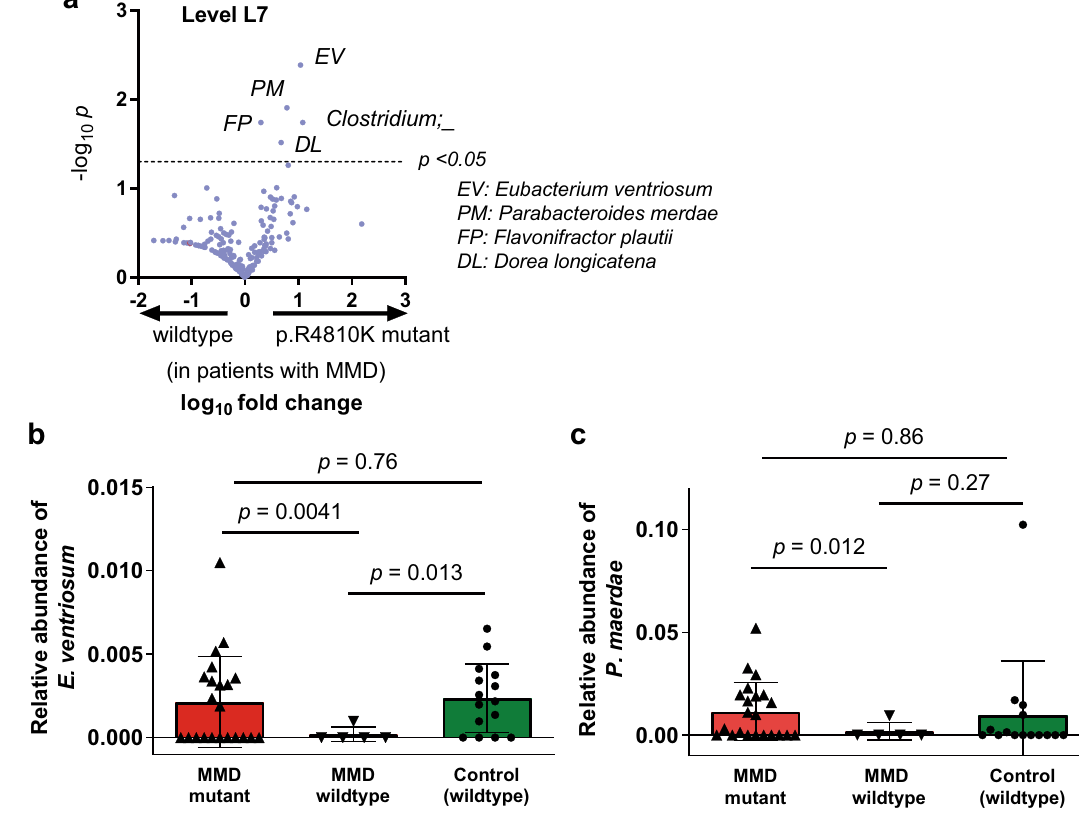
Figure 6. Relative abundance analysis of gut microbiota according to the p.R4810K mutation. ( a ) Relative abundances of gut microbiota were compared between MMD patients with the p.R4810K mutation and those without it. Eubacterium ventriosum ( E. ventriosum ) showed the lowest p value, followed by Parabacteroides merdae ( P. merdae ), Clostridium , Flavonifractor plautii , and Dorea longicatena . ( b-c ) Relative abundance of E. ventriosum ( b ) and that of P. merdae ( c ) was compared among MMD patients with the p.R4810K mutation (homozygotes and heterozygotes), MMD patients without the mutation, and control individuals (without the mutation). In either analysis, there was no significant difference between patients with the p.R4810K mutation and control individuals. Bars and whiskers indicate means and standard